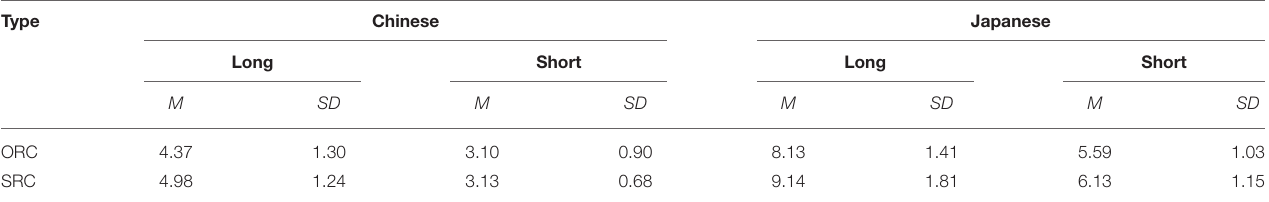
TABLE 3 | Mean (M) and standard deviation (SD) values for Reading time of full sentences (sec).